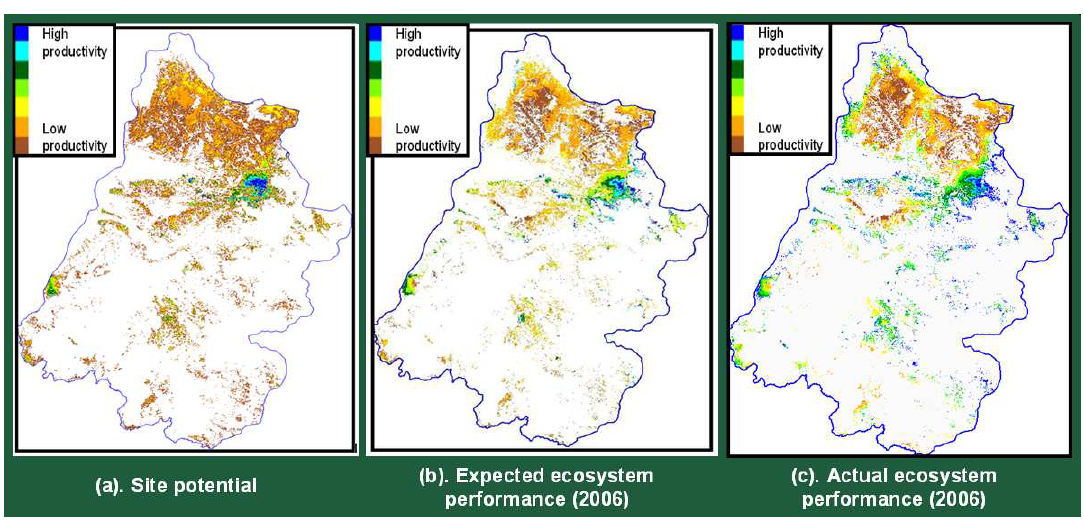
Figure 3. Examples of site potential map, EEP map, and the actual EP map for big sagebrush in the UCRB. (a) Modeled big sagebrush site potential map; (b) 2006 EEP map for big sagebrush; (c) 2006 actual EP